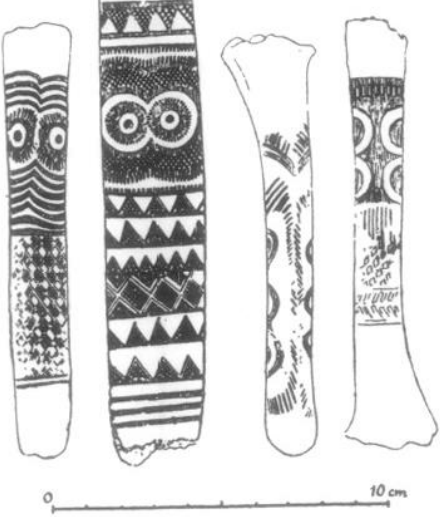
Figure 2. Carved tibiae with ‘owlglassy bicycles’ ( FW 208.9) from Almizaraque in south-east Spain Figure 2 . Carved tibiae w ith ‘owlglassy bicycles’ ( FW 208.9) from Almizaraque in south-east Spain (Luquet 1911, p. 443, after Siret (Luquet 1911, p. 443, after Siret 1908).